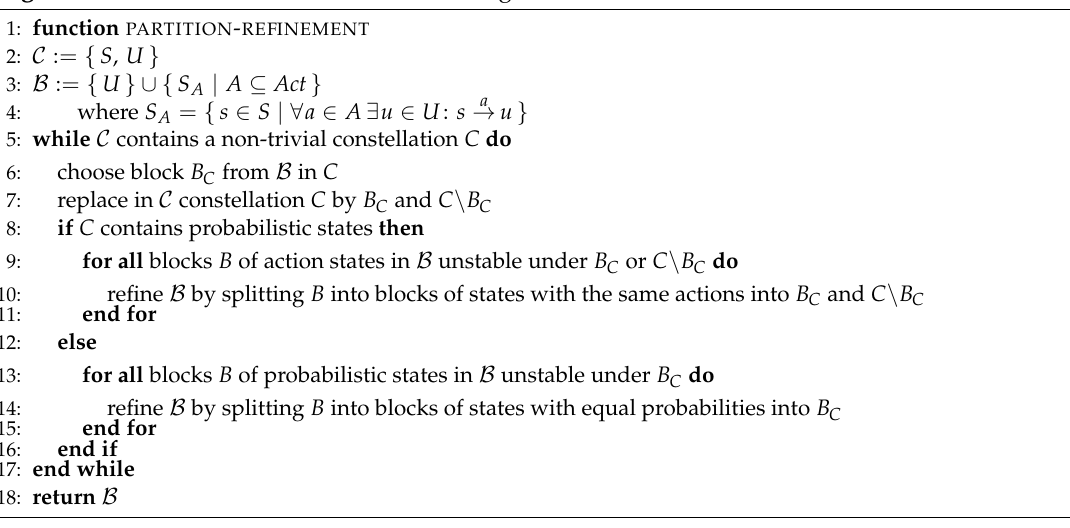
Algorithm 1 Abstract Partition Refinement Algorithm for Probabilistic Bisimulation.